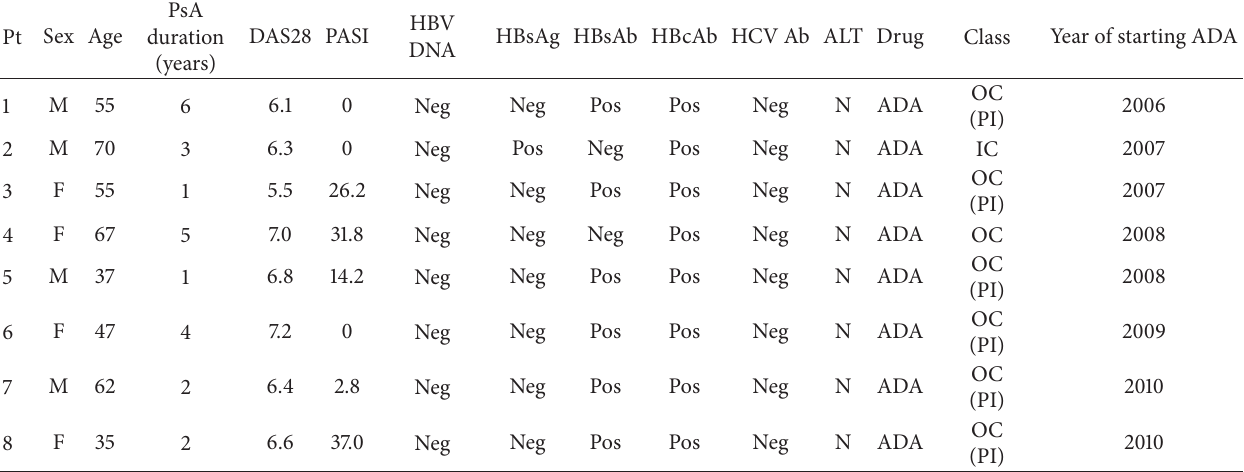
Table 2: Patient’s baseline characteristics.